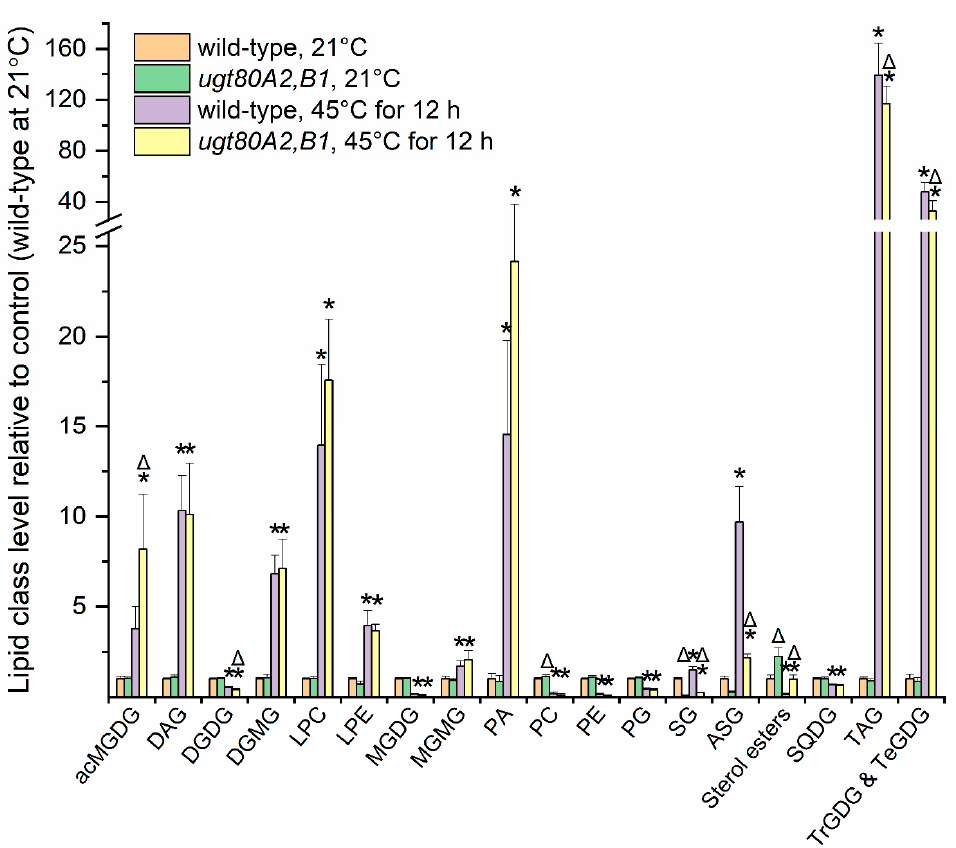
Figure 9. Levels of lipid head group classes in wild-type and ugt80A2,B1 double mutant Arabidopsis leaves after severe heating treatment of 12 h at 45 ◦ C. Asterisks indicate a significant di ff erence in lipid level due to the heating treatment (compared with the same genotype held at 21 ◦ C). Triangles indicate a di ff erence in ugt80A2,B1 double mutant plants versus wild-type plants under the same treatment conditions. Di ff erences were evaluated by one-way ANOVA with Tukey’s multiple comparisons test, adjusted for FDR. A p -value < 0.05, after correction for false discovery rate, was considered significant. Error bars indicate standard deviation. Table 1. Leaf viability in wild-type versus ugt80A2,B1 double mutant plants in response to a 12-h heat treatment at 45 ◦ C at 30 day (d) of age. The number of rosette leaves of untreated plants was determined at 30 d and 42 d. Leaves of treated plants were counted 12 d after the onset of the 12 h heat treatment. Student’s t -test indicated that the untreated double mutant plants had fewer leaves at 42 d than wild-type plants ( p < 0.05). However, the number of leaves in heat-treated wild-type and ugt80A2,B1 double mutant plants was not significantly di ff erent. Number of Viable Rosette Leaves n (Number of Plants of Each Line) Wild-Type ugt80A2,B1 Double Mutant Untreated, grown at 21 ◦ C (30 d) 324 Untreated control, grown at 21 ◦ C (42 d) Treated at 45 ◦ C for 12 h at 30 days, otherwise grown at 21 ◦ C (42